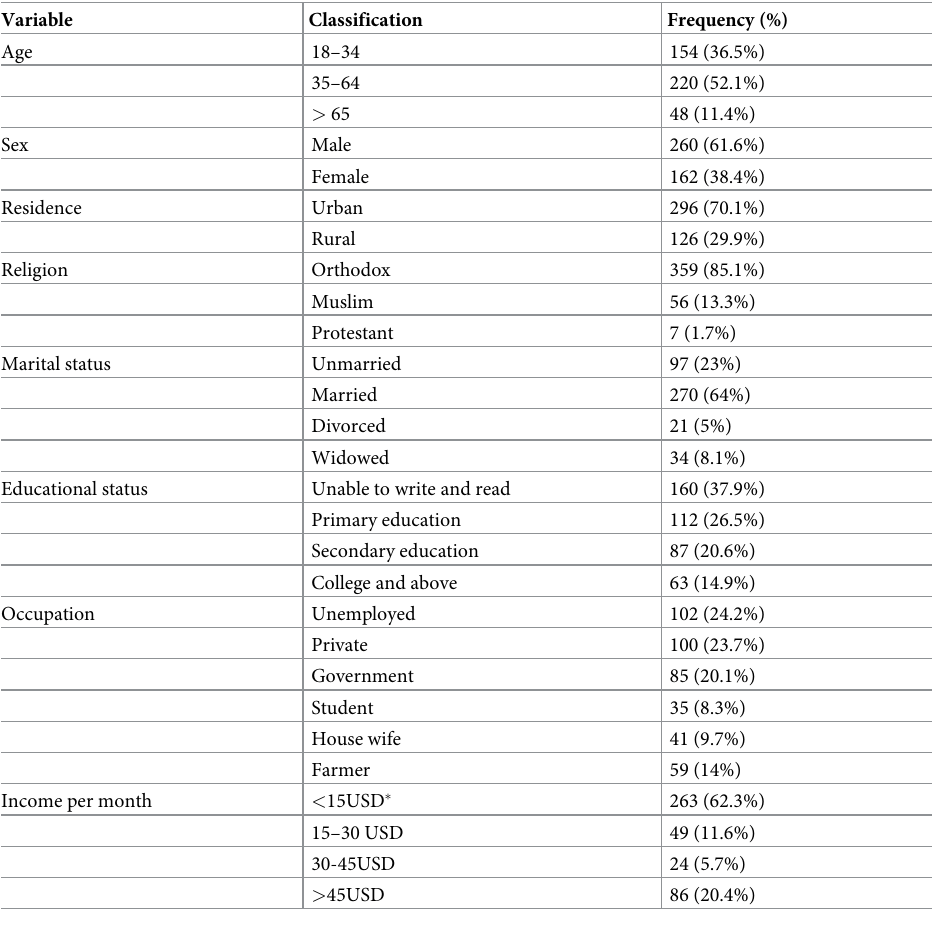
Table 1. Socio demographic characteristic of study participants, UoGRTH, North-West Ethiopia, 2019 (N = 422).